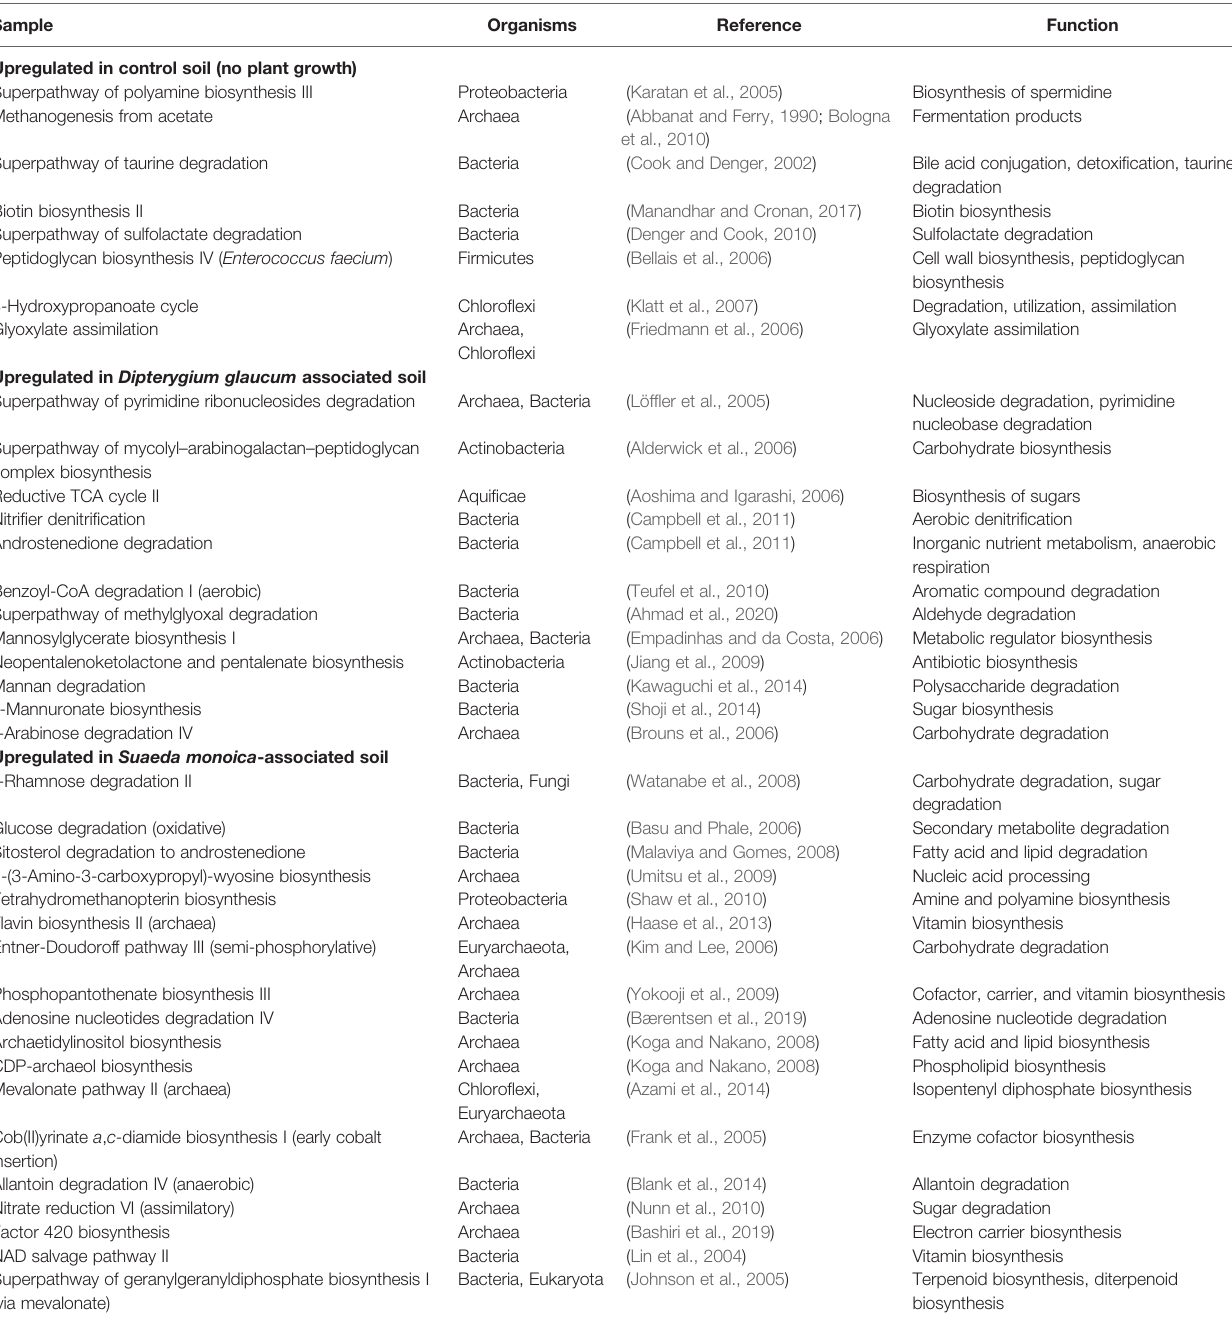
TABLE 2 | Pathways that were upregulated in certain samples and their